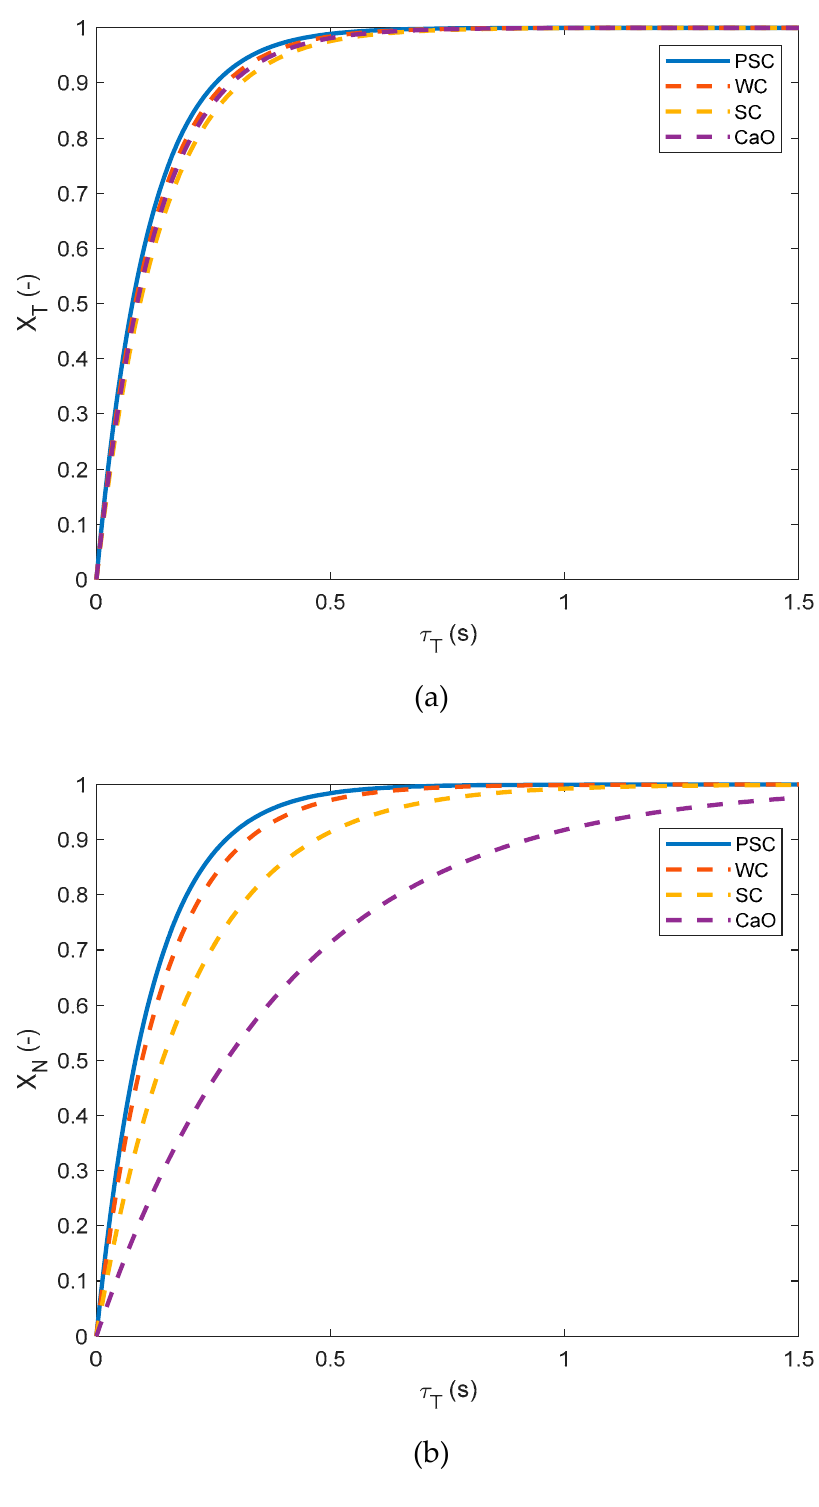
Figure 12. ( a ) Toluene; and ( b ) naphthalene conversion as a function of theoretical residence time at 900 °C for different active materials.